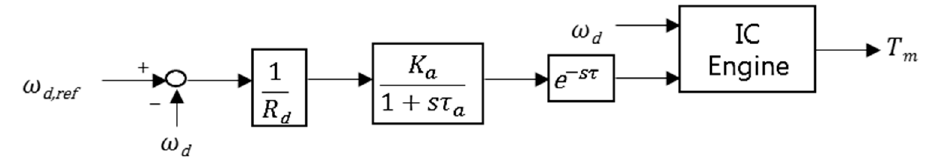
Figure 3. Governor control of the diesel generator set.